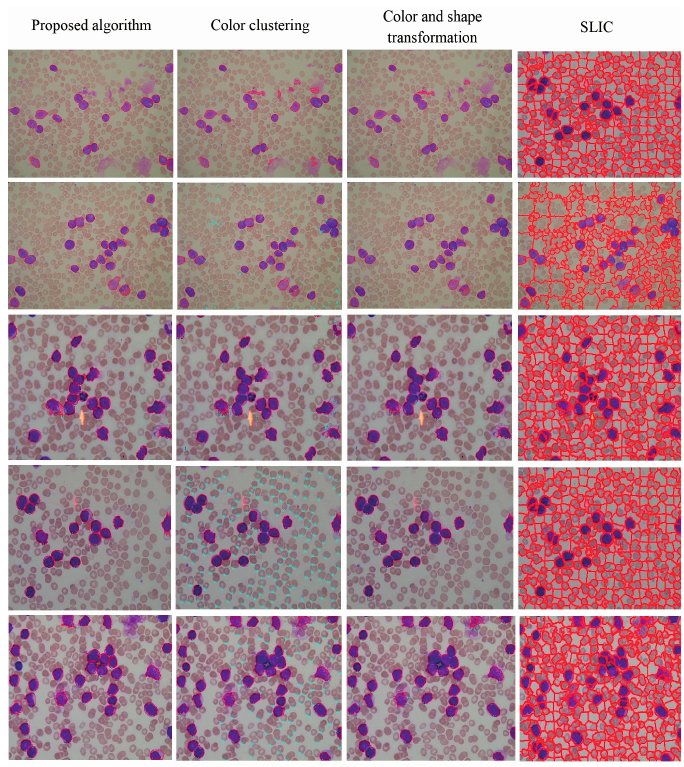
Figure 18. Segmentation results of images with disease in the ALL-IDB1 dataset (segmented WBCs marked with red curves).